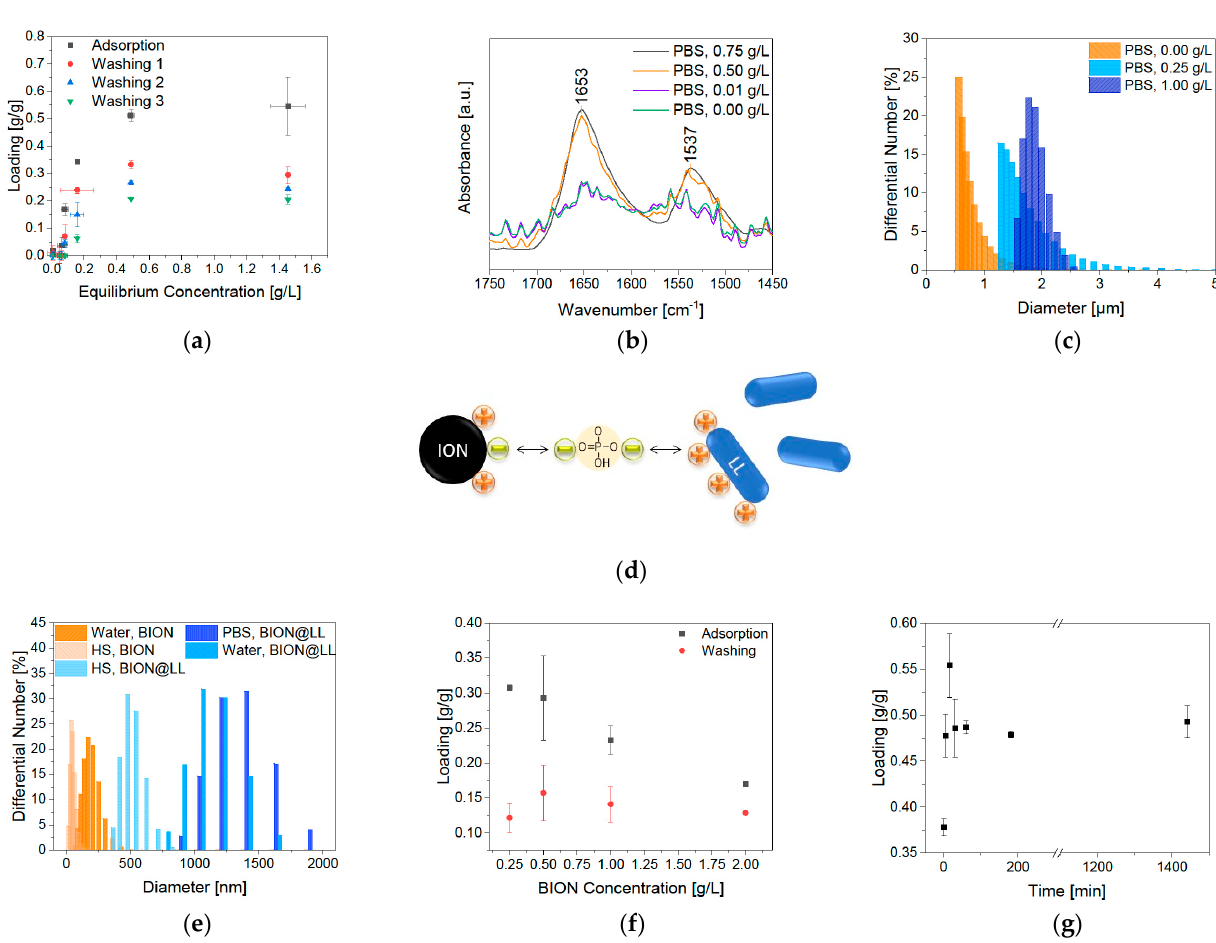
Figure 6. ( a ) Adsorption isotherms of LL at pH 7.4 in 50 mM PBS buffer and 1 g/L of BIONs, ( b ) FTIR spectra of adsorbed LL on BIONs, ( c ) hydrodynamic diameters after LL adsorption at pH 7 in 50 mM PBS buffer, ( d ) illustration of the BION LL interaction in dependence with PBS buffer ( e ). Agglomeration behavior of BIONs and BION@LL in water, human serum (HS) and PBS buffer, ( f ) binding kinetic of 1 g/L LL at pH 7.4 in 50 mM PBS and 1 g/L of BIONs, and ( g ) adsorption of 0.5 g/L LL at pH 7.4 in 50 mM PBS at different BION concentrations.